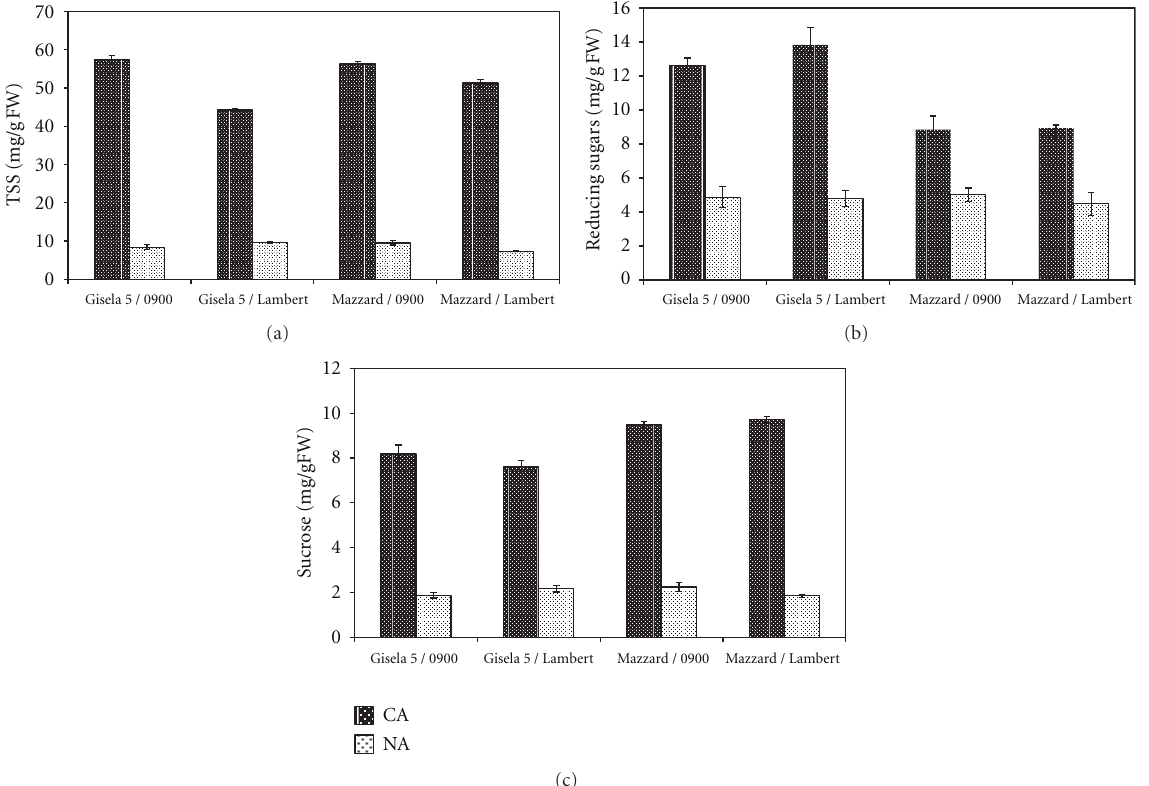
Figure 2: TSS (a), reducing sugars (b), and sucrose (c) contents in cold-acclimated (CA, in January) and nonacclimated (NA, in July) bark tissues of sweet cherry cultivars grafted on di ff erent rootstock. FW: fresh weight. Error bars represent ± SE of three